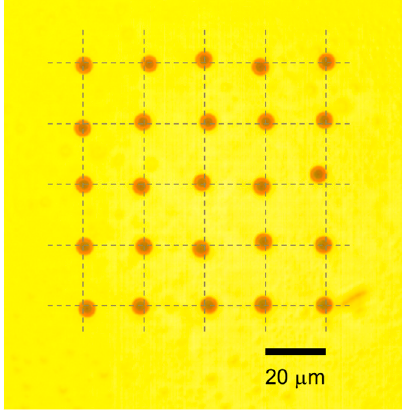
Figure 12. Photomicrograph of the CR-39 detector etched by a solution after 5 × 5 single-ion hits of the 260 MeV 20 Ne 7+ without flat-top (FT) acceleration. The CR-39 was placed in the air at a distance of 1 mm from the vacuum window. The intersections of broken lines show the target points.